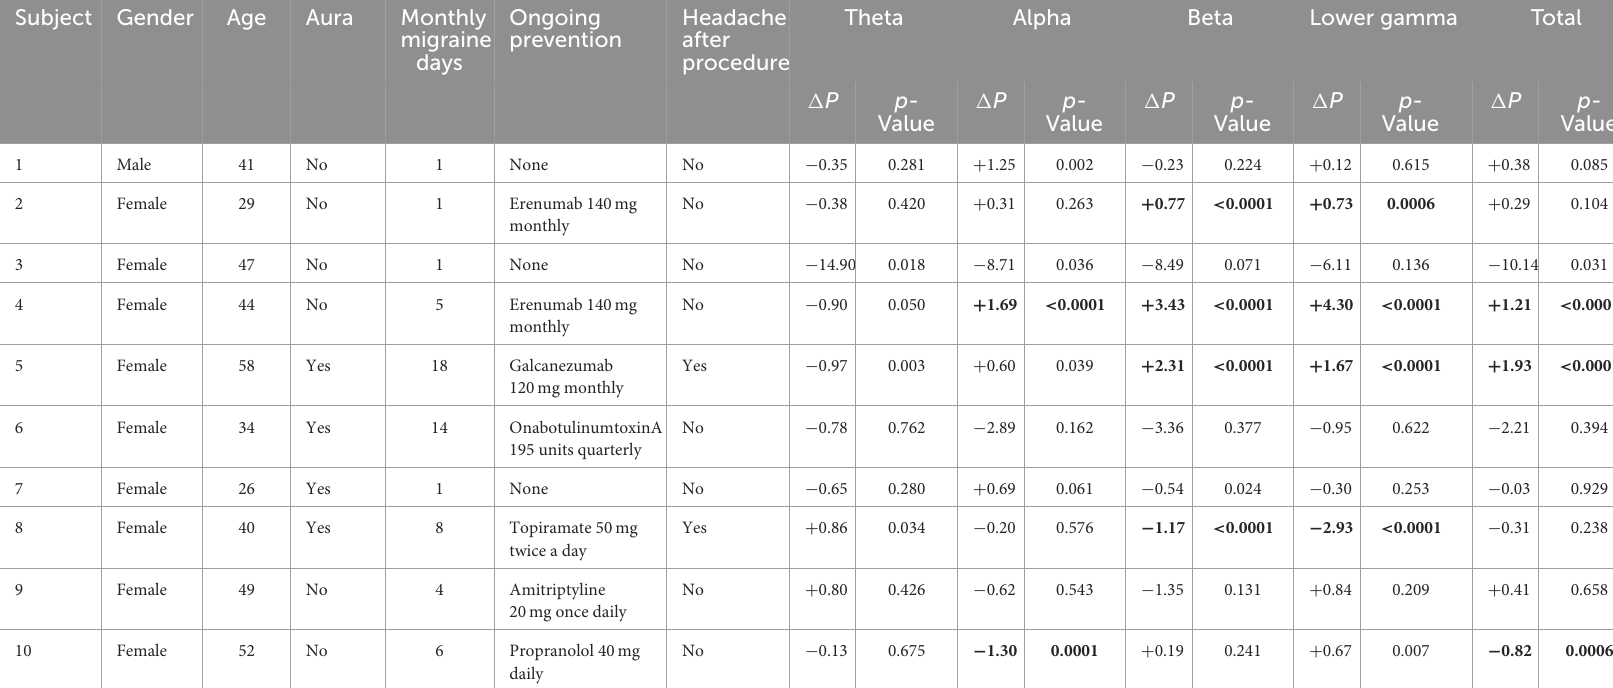
TABLE 1 Characteristics of the included subjects and global power change in the different frequency